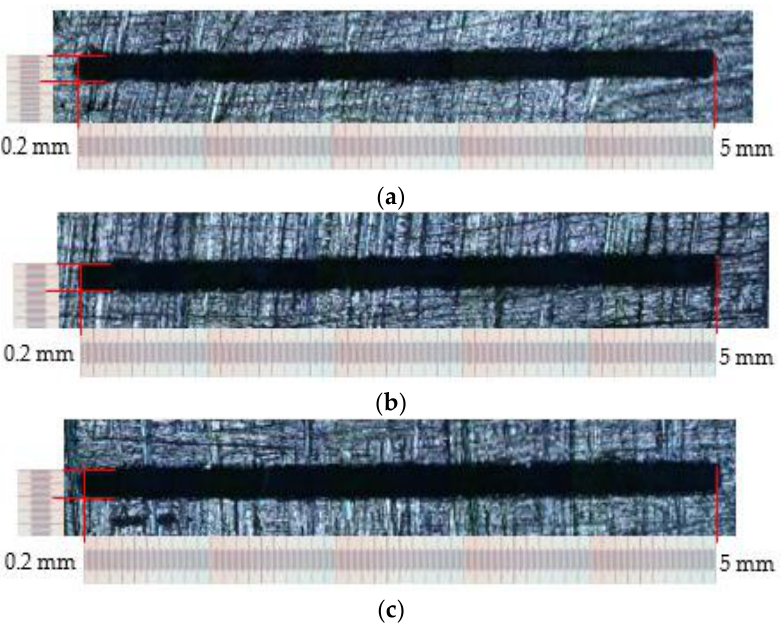
Figure 3. Microscopic analysis: measurement of length and width of the cracks with ( a ) depth = 0.3 mm, ( b ) depth = 0.5 mm, and ( c ) depth = 1 mm.